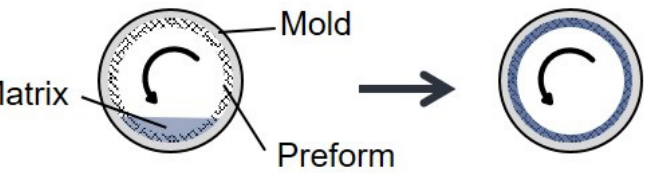
Figure 1. Simplified representation of the rotational molding process with thermoset